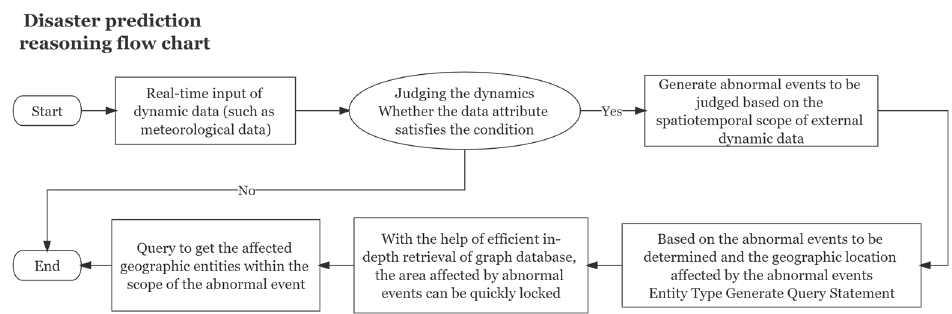
Figure 9. Disaster prediction query flow chart.